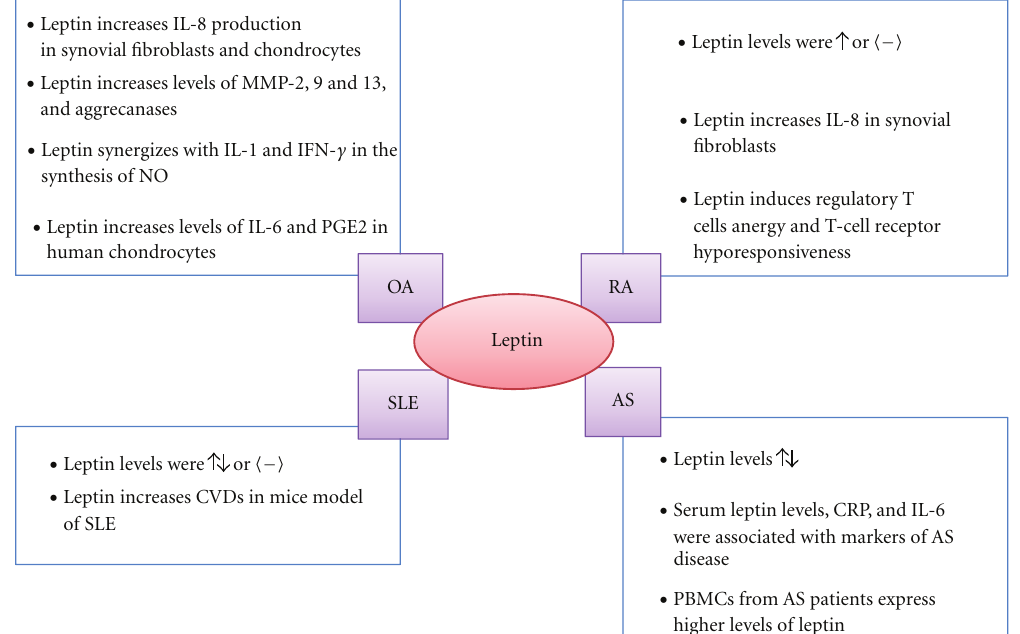
Figure 2: Schematic representation of leptin implication in several rheumatic